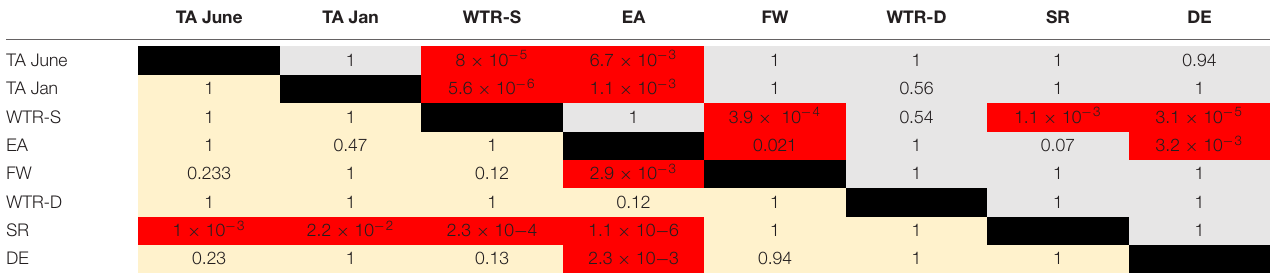
TABLE 2 | Relationships between oocyte sizes and fecundity amongst sites. TA June TA Jan WTR-S EA FW WTR-D SR DE TA June